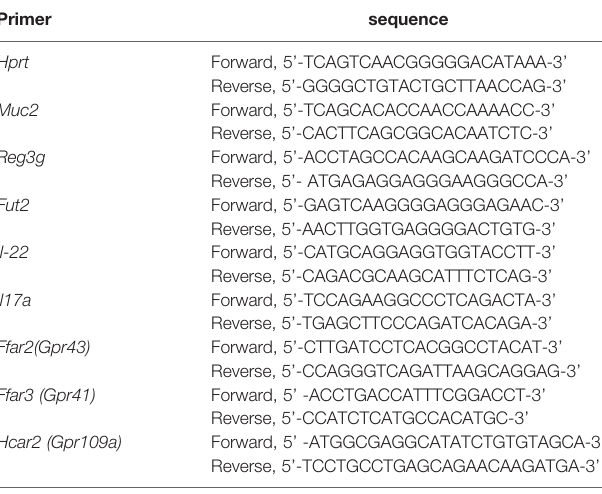
TABLE 2 | Primers used in the